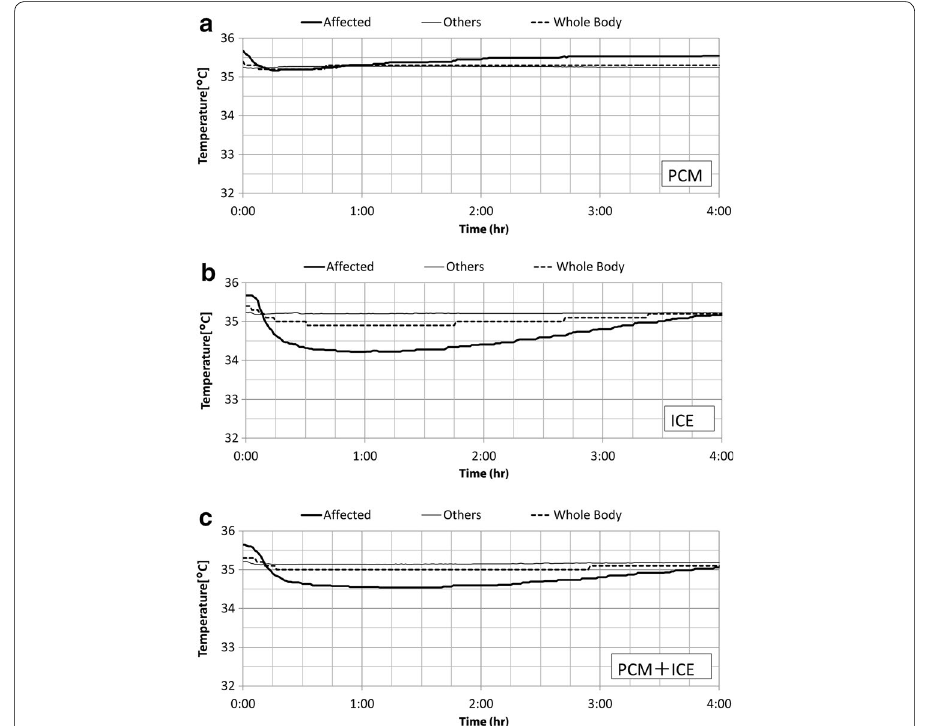
Fig. 8 Temperature of VEST. a PCM, b ICE, c PCM